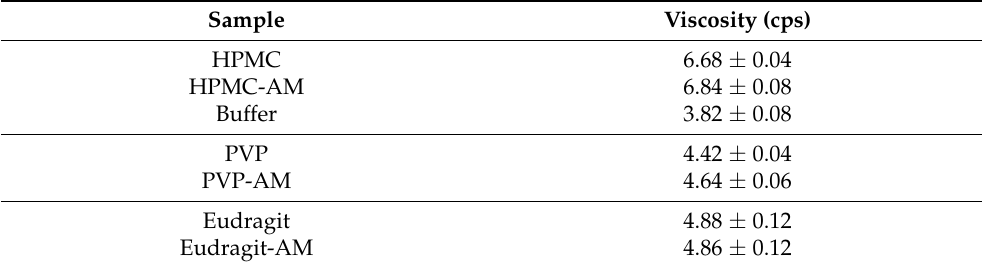
Table 2. Result of viscosity measurement of each